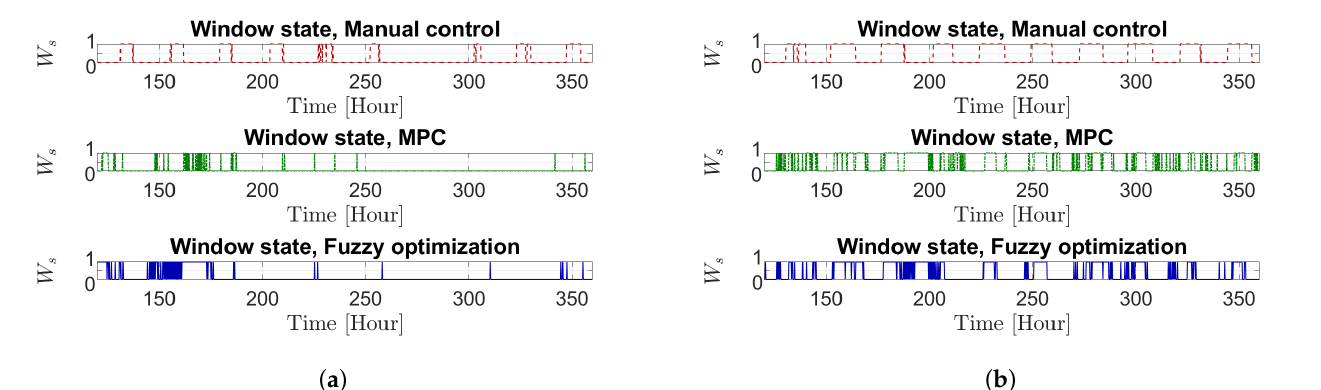
Figure 9. State of the openness of windows obtained during the simulations. Both graphs correspond to the simulation results obtained when using climate data from the winter and summer seasons. ( a ) Window state when using winter data; ( b ) window state when using summer data.